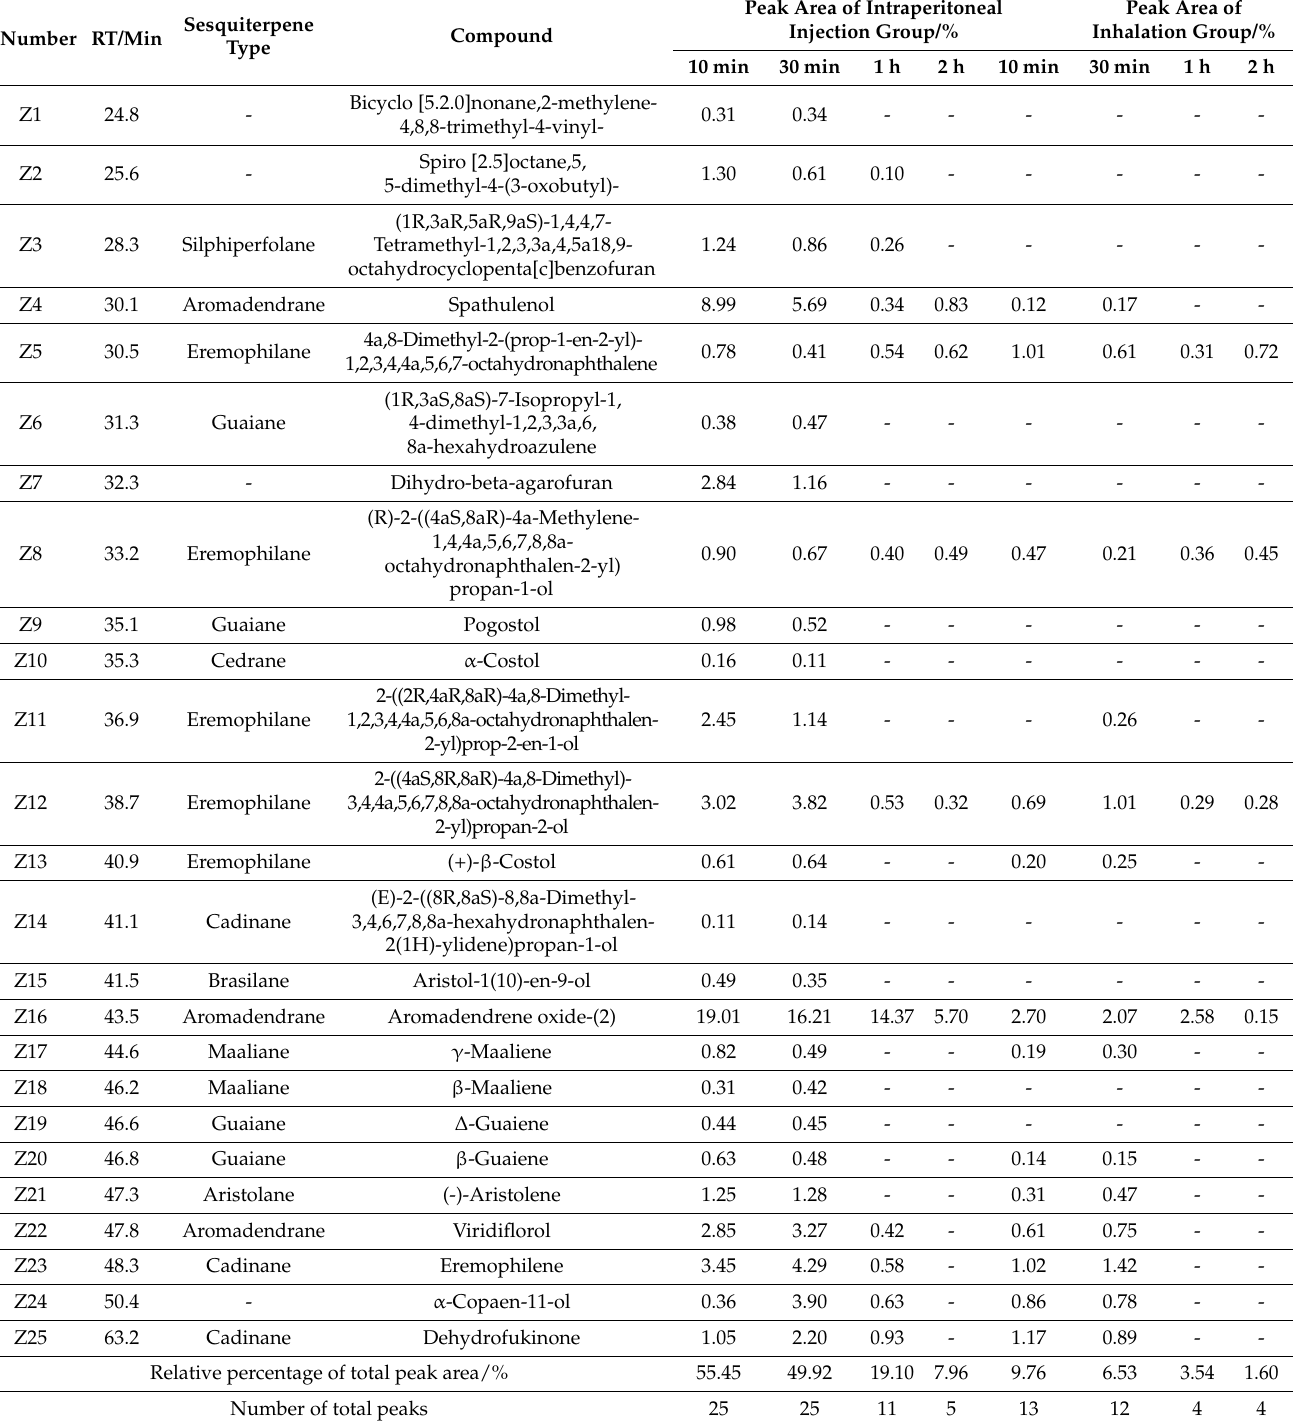
Table 1. Chemical composition of the 25 blood compounds identified in serum